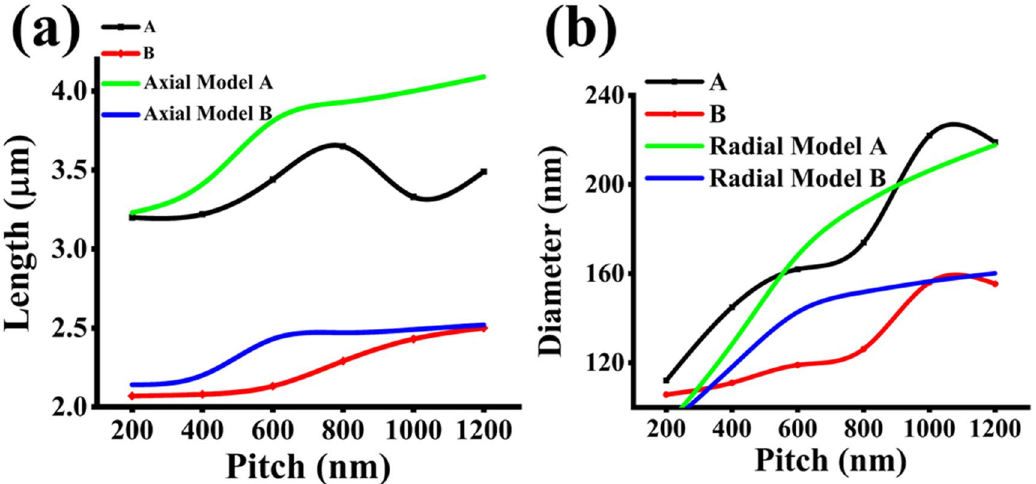
Figure 8. Growth rate model results for ( a ) length and ( b ) diameter in both samples A and